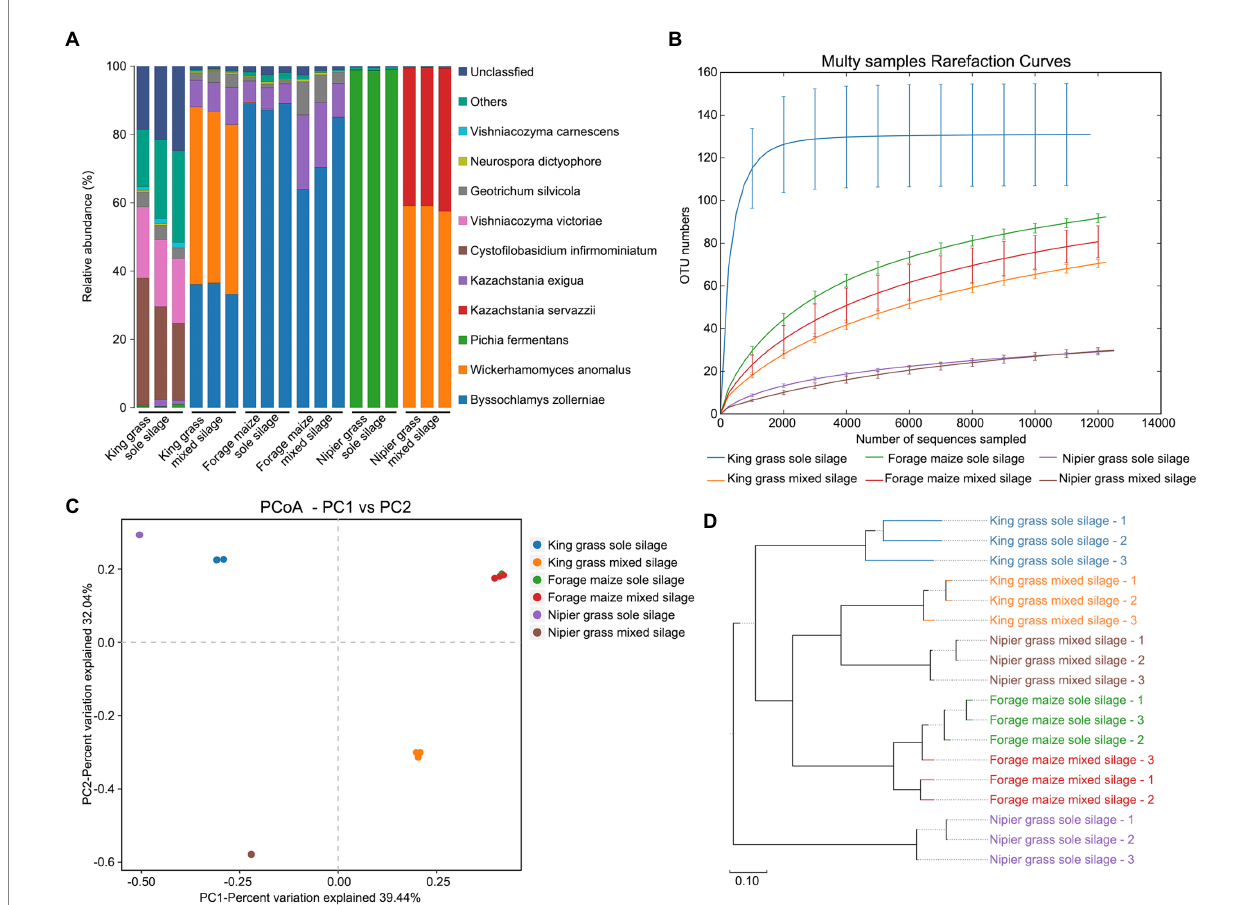
FIGURE 3 Diversity of fungal communities between sole and mixed silages. (A) Relative abundance of bacteria at the species level. (B) Rarefaction curves for α -diversity measures of operational taxonomic units (OTUs) comparing fungal communities from sole and mixed silages. Error bars correspond to one standard deviation from the average ( n = 3 biological replicates). (C) Unconstrained principal coordinates analysis (PCoA) (for principal coordinates PCo1 and PCo2) with weighted UniFrac distance showing that fungal communities in different samples separate in the first axis ( p < 0.001, PERMANOVA). (D) Hierarchical clustering trees in unweighted pairwise average method (UPGMA) analysis. Distance matrices were obtained by the weighted UniFrac distance algorithm. The samples that are closer (with shorter branch length) share higher similarity in species composition.